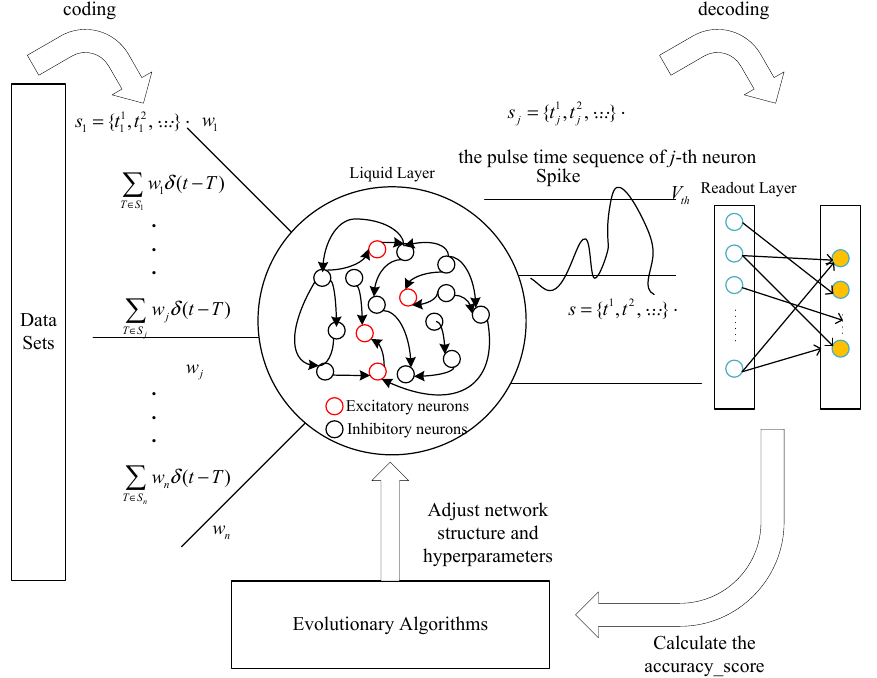
Figure 3. LSM design based on the evolutionary algorithm